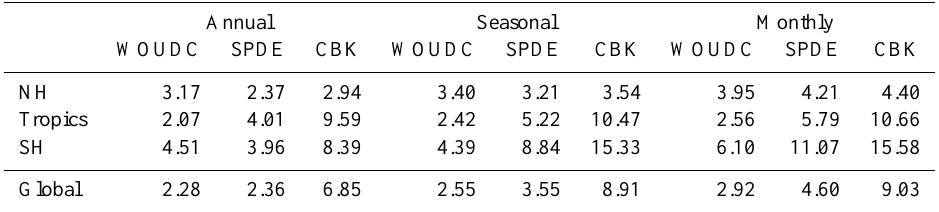
Table 8. RMSEs of annual, seasonal and monthly total mean ozone from WOUDC data set, and SPDE and covariance-based kriging (CBK) estimated means (using 57 stations) against SBUV data over 1990–2010. Annual Seasonal Monthly WOUDC SPDE CBK WOUDC SPDE CBK WOUDC SPDE CBK